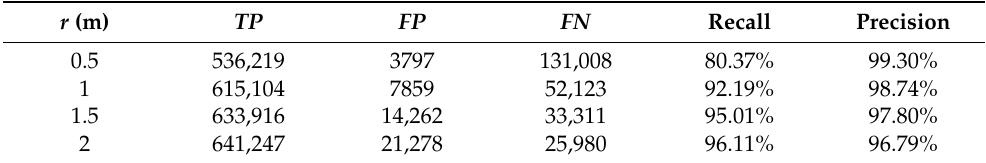
Table 1. The recall and precision evaluation results of plot